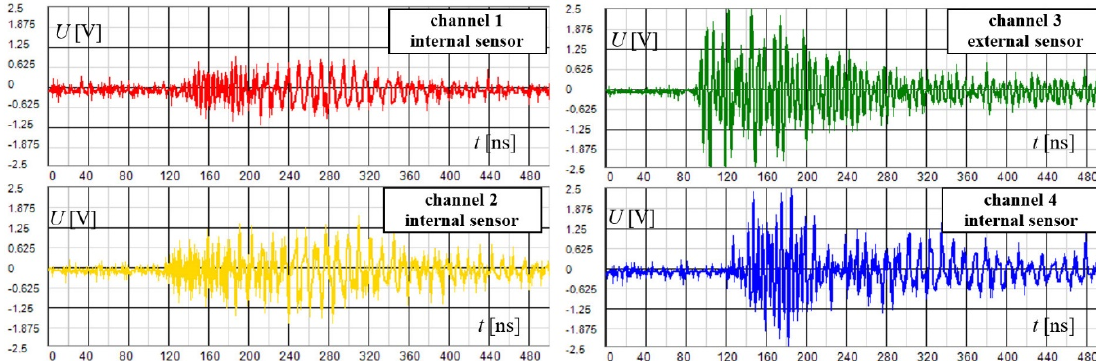
Figure 21. The waveforms of the disturbing signal acquired within the external sensor mode; the external sensor connected to channel 3 (CH3).